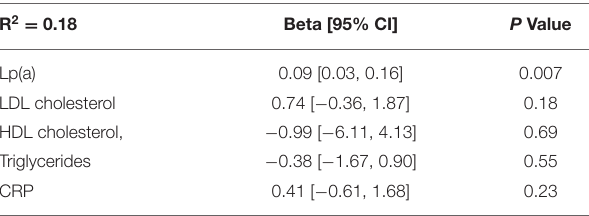
TABLE 4 | Association between the changes of plasma lipoproteins and CAC progression. R 2 =